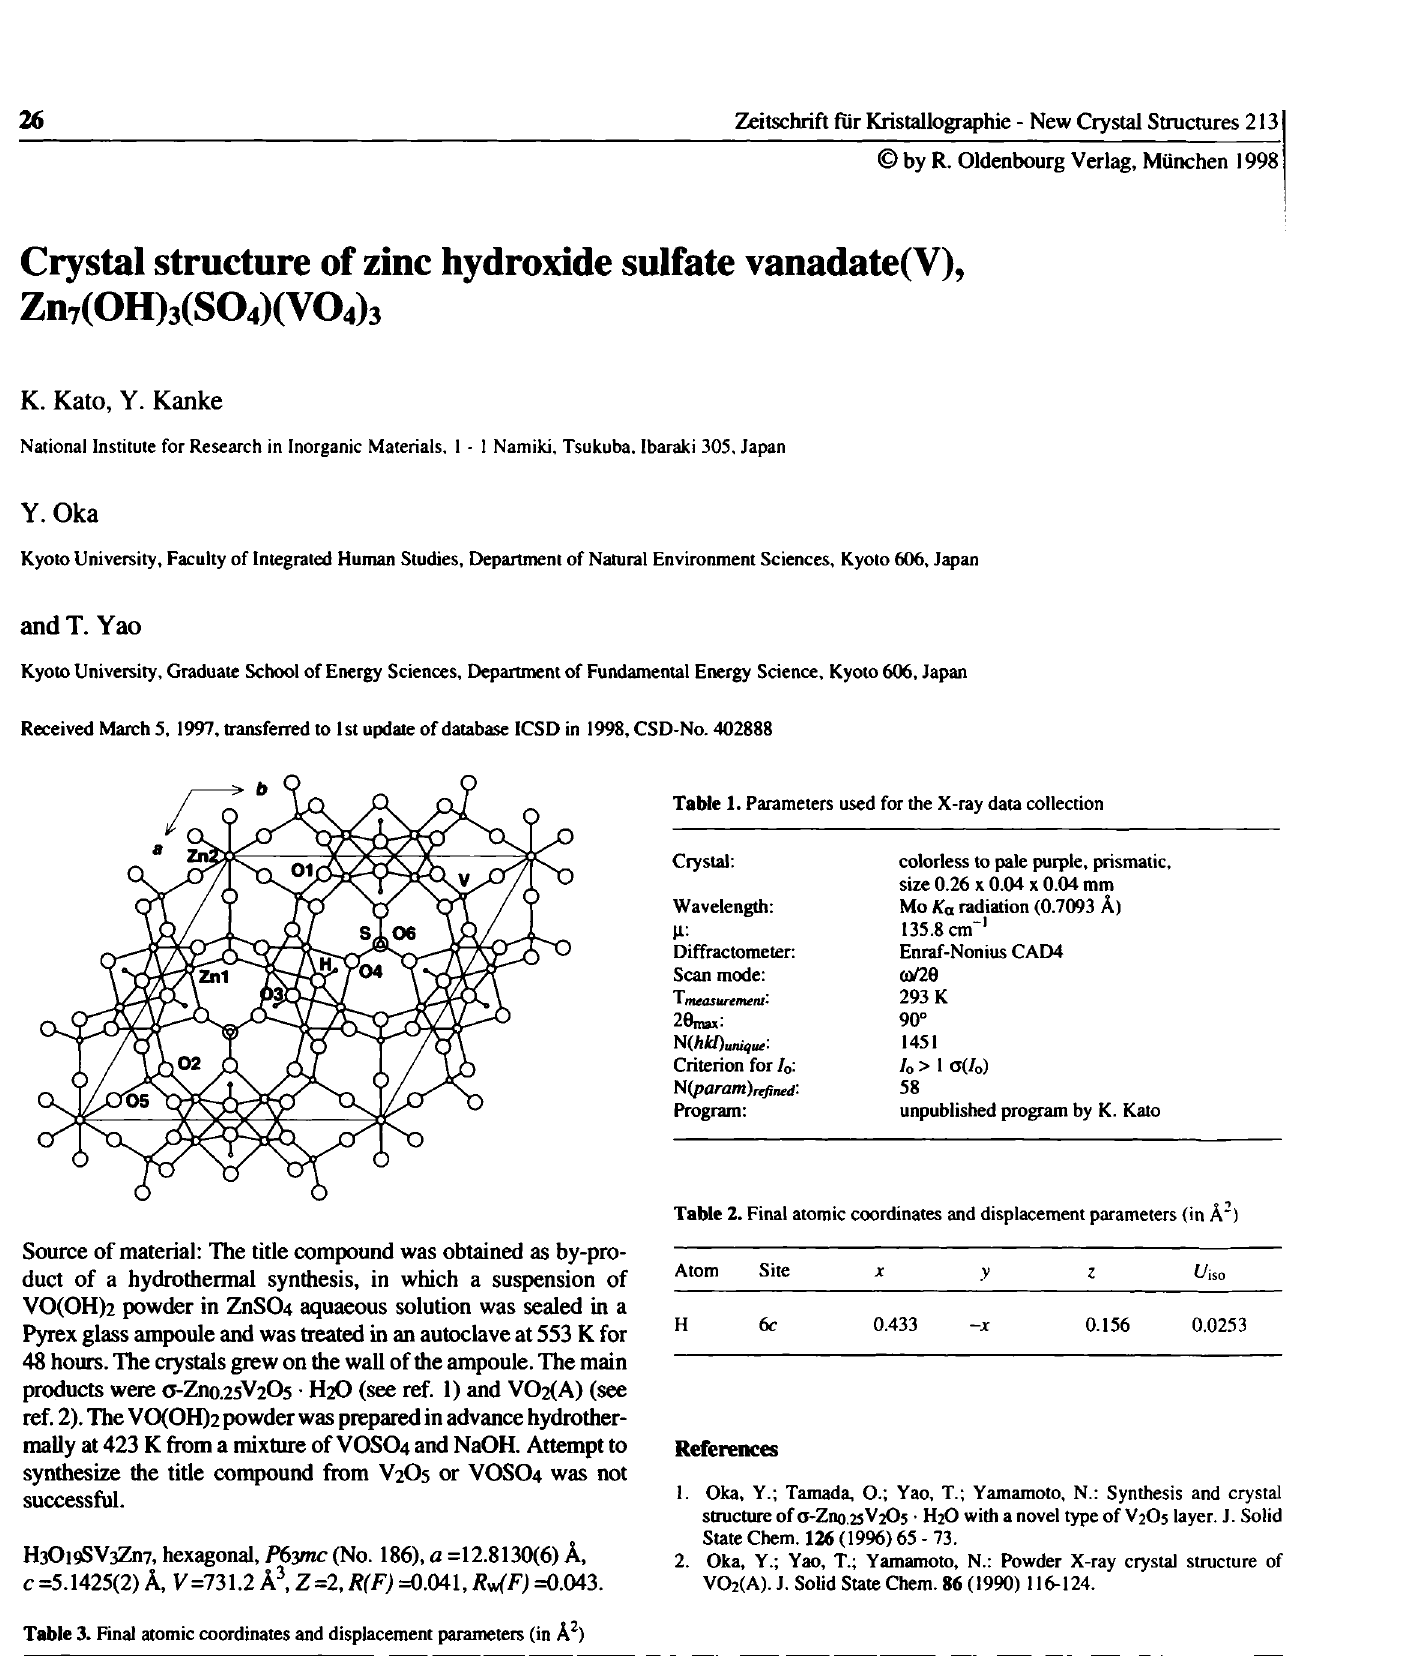
Table 3. Final atomic coordinates and displacement parameters (in Â^)